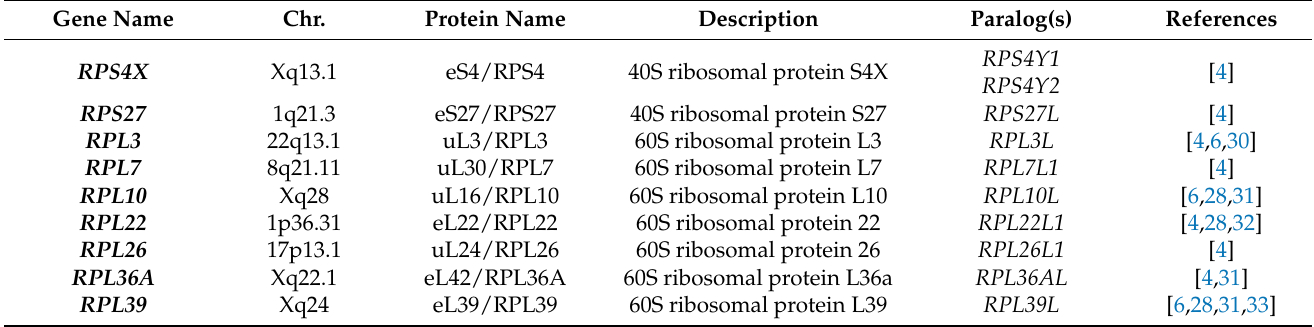
Table 1. Mammalian ribosomal protein